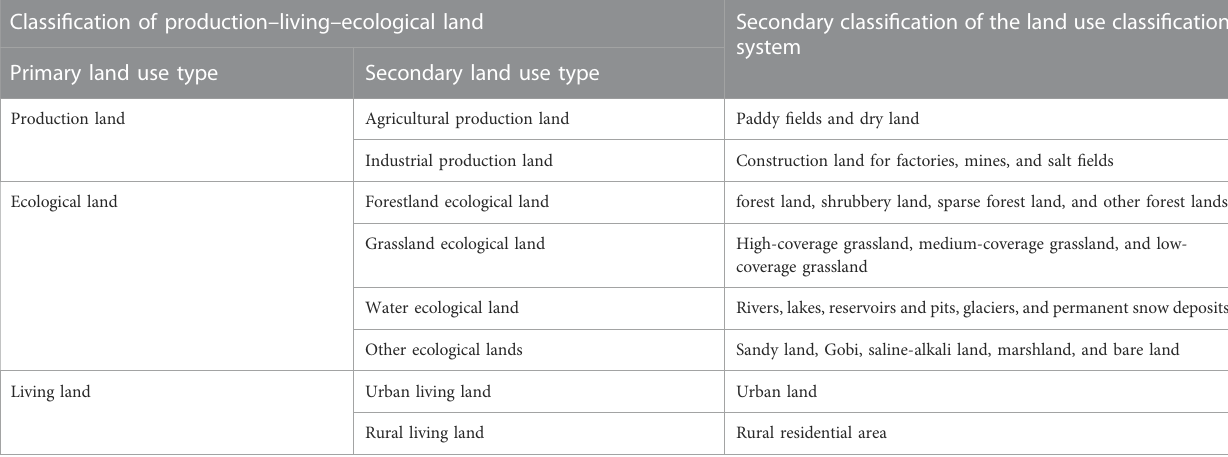
TABLE 2 Land use types based on the dominant